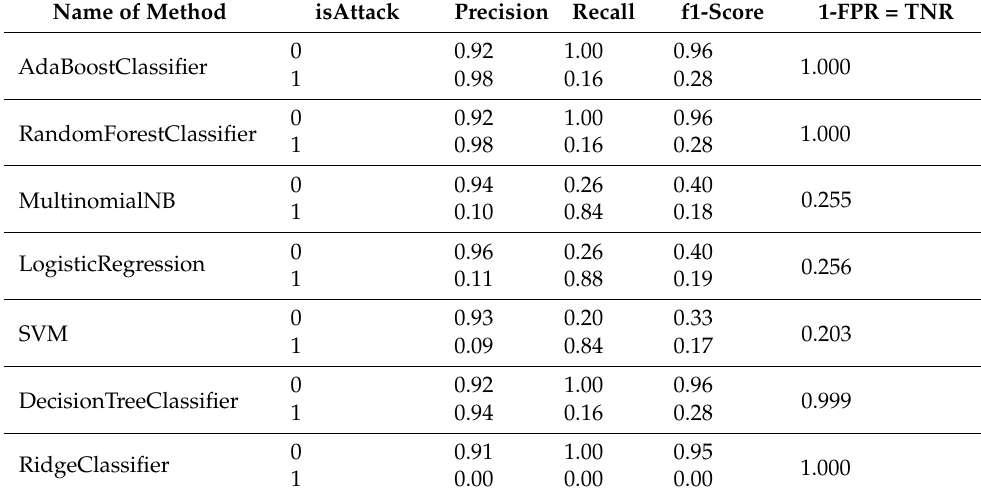
Table 3. Classification quality for 1_portsweep_warezclient.csv.